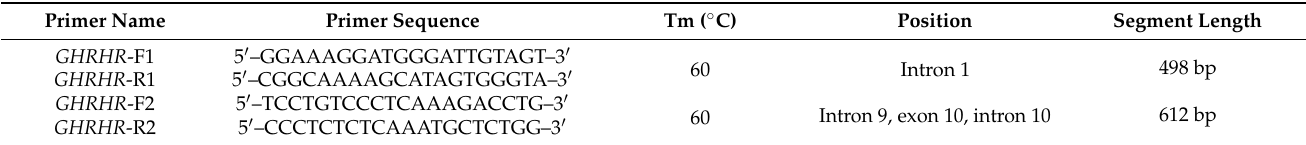
Table 1. Primers used for PCRanalysis in GHRHR